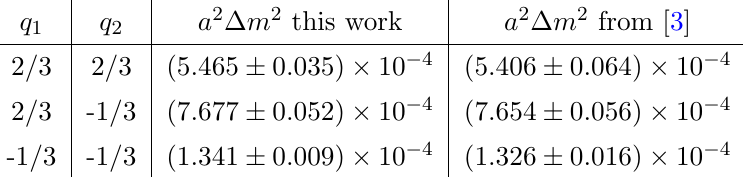
Table 2 . Comparison of pion squared mass splittings from the stochastic data and the results of a previous calculation in [3]. Results are given in lattice units. q 1 and q 2 denote the charges of the valence quarks in units of e . Both data sets use the Feynman gauge for the photon (cid:12)elds. di(cid:11)erent gauge con(cid:12)gurations. A comparison of our results with the results from this